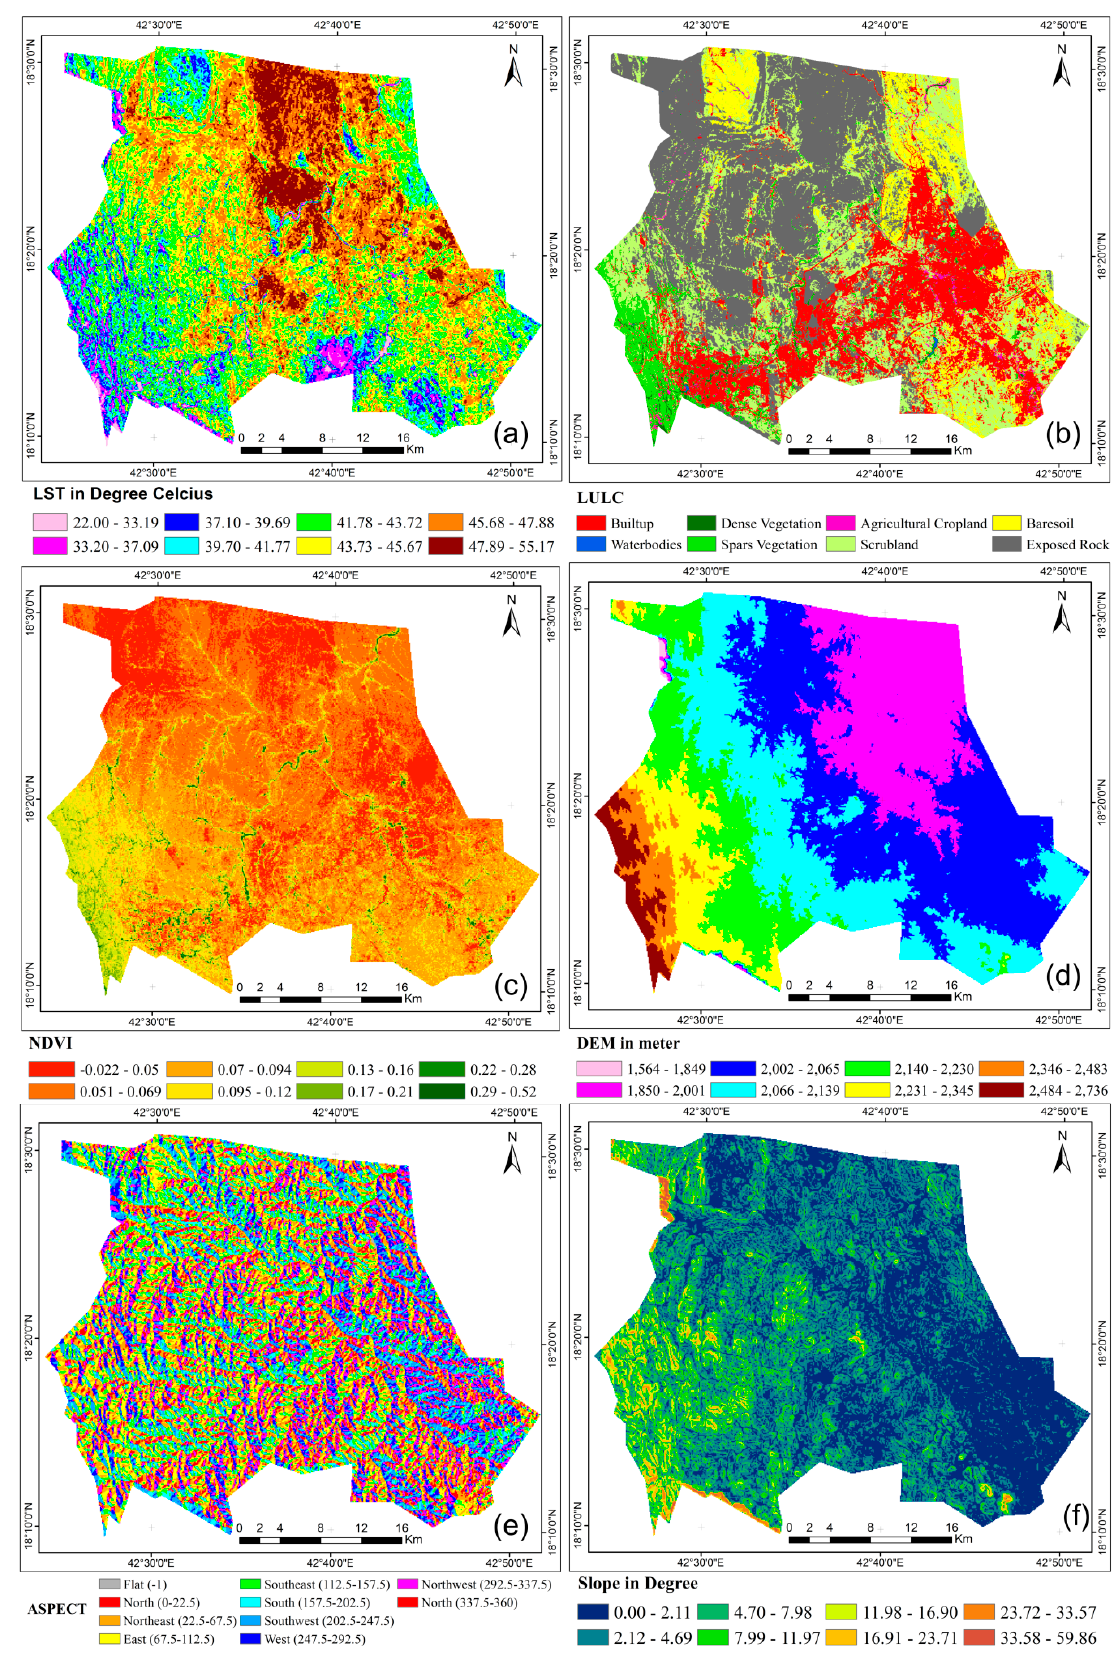
Figure 4. Spatial distribution of LST ( a ), LULC ( b ), NDVI ( c ), DEM ( d ), Aspect ( e ), and Slope ( f ).